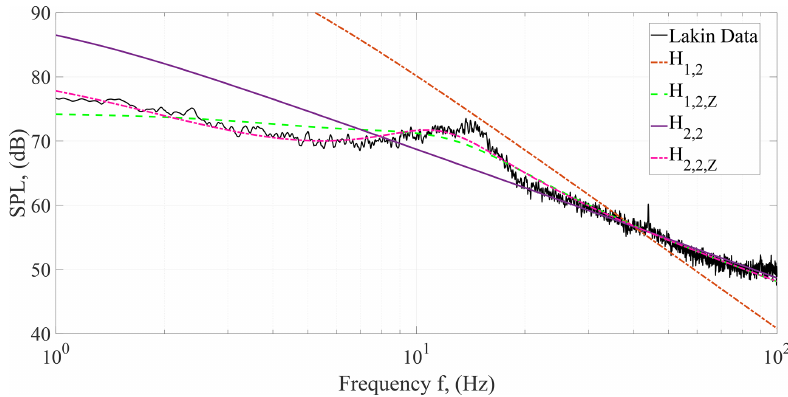
Figure 16. Comparison of frequency-domain model fits to Lakin, KS, tornado measurements. Table 5. Median fit parameters uncertainty distribution as quantified by Monte Carlo convergence over 1000 initial